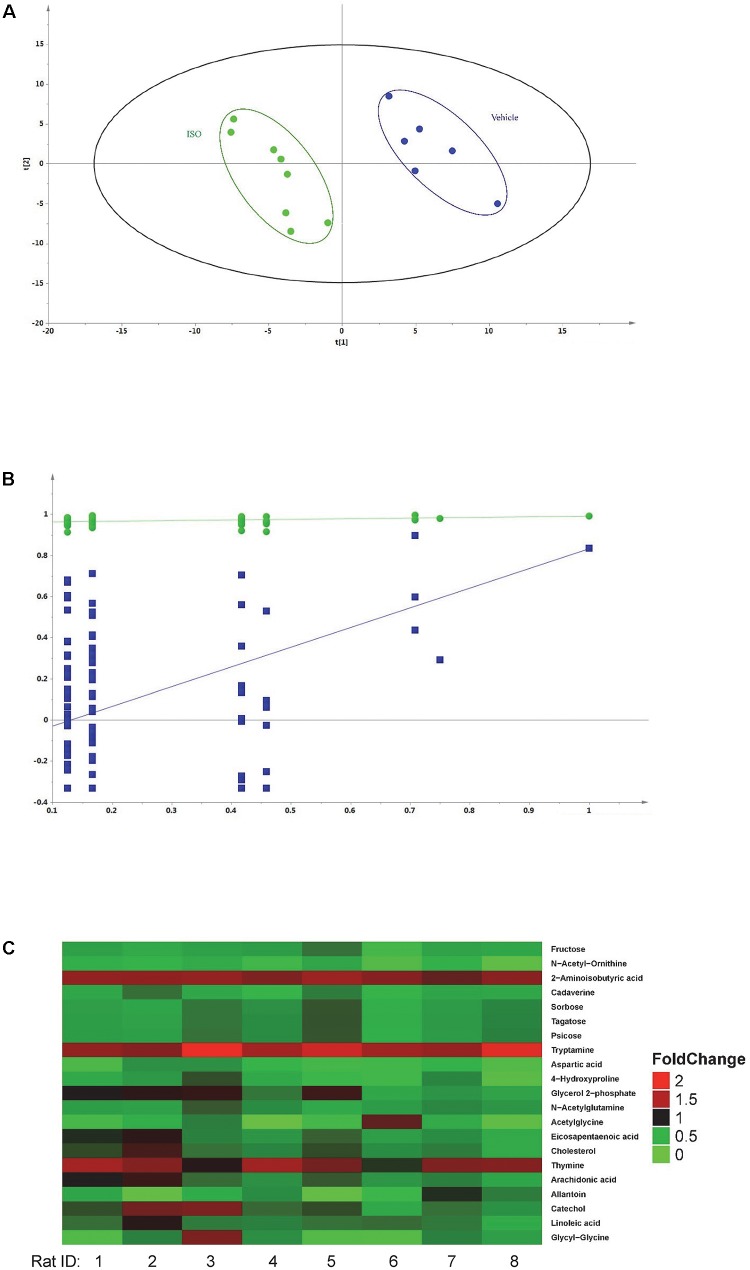
Metabolomics of isorhapontigenin. (A) Results of PLS-DA. Green •: rats received 1-week ISO intervention and blue •: rats received vehicle. (B) Results of permutation test. Green •: R2 (goodness-of-fit parameter) and blue ■: Q2 (goodness-of-prediction parameter). (C): Fold change heatmap of plasma metabolites altered by 1-week ISO intervention.